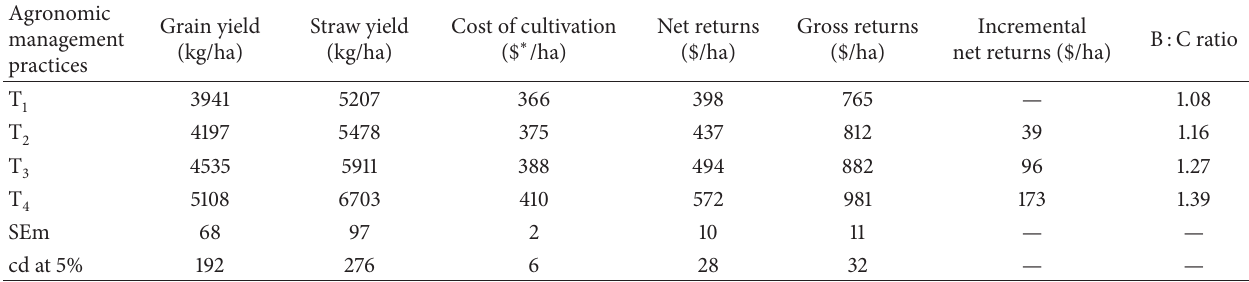
Table 2: Grain and straw yield and economics of different agronomic management practices in rice crop (pooled data of four years). Agronomic